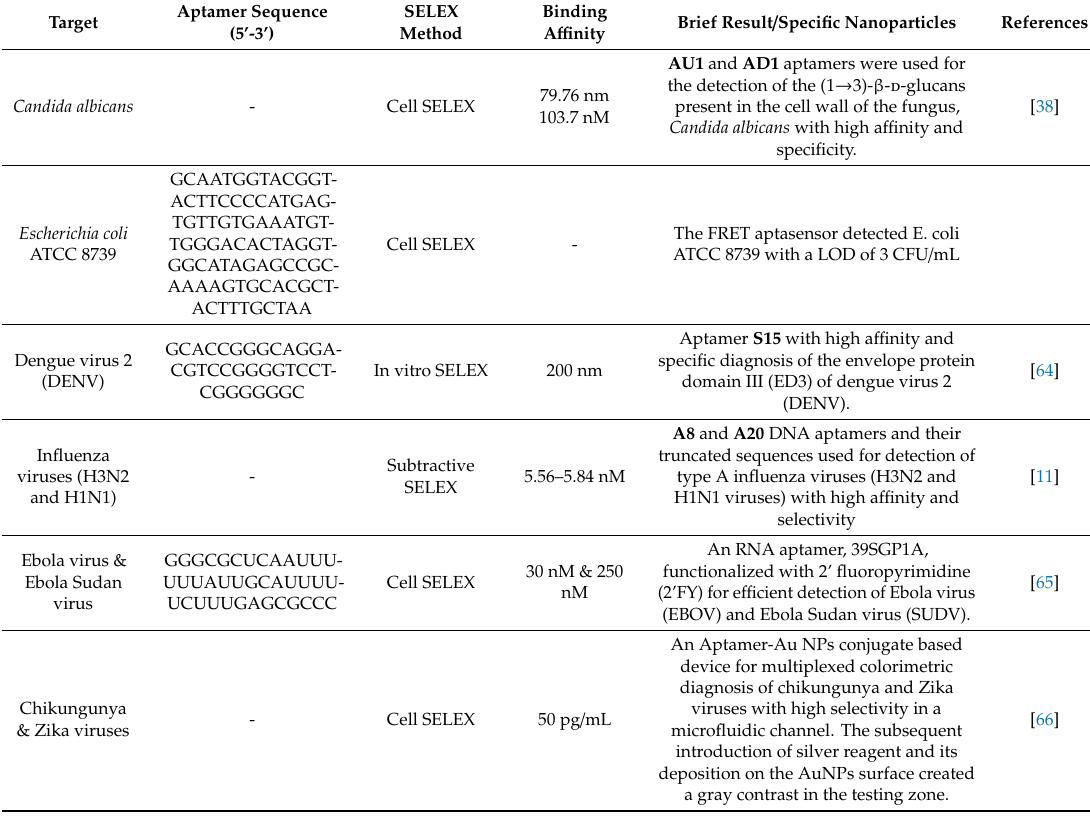
Table 2. A list of aptamers in the literature applied for the detection of infectious